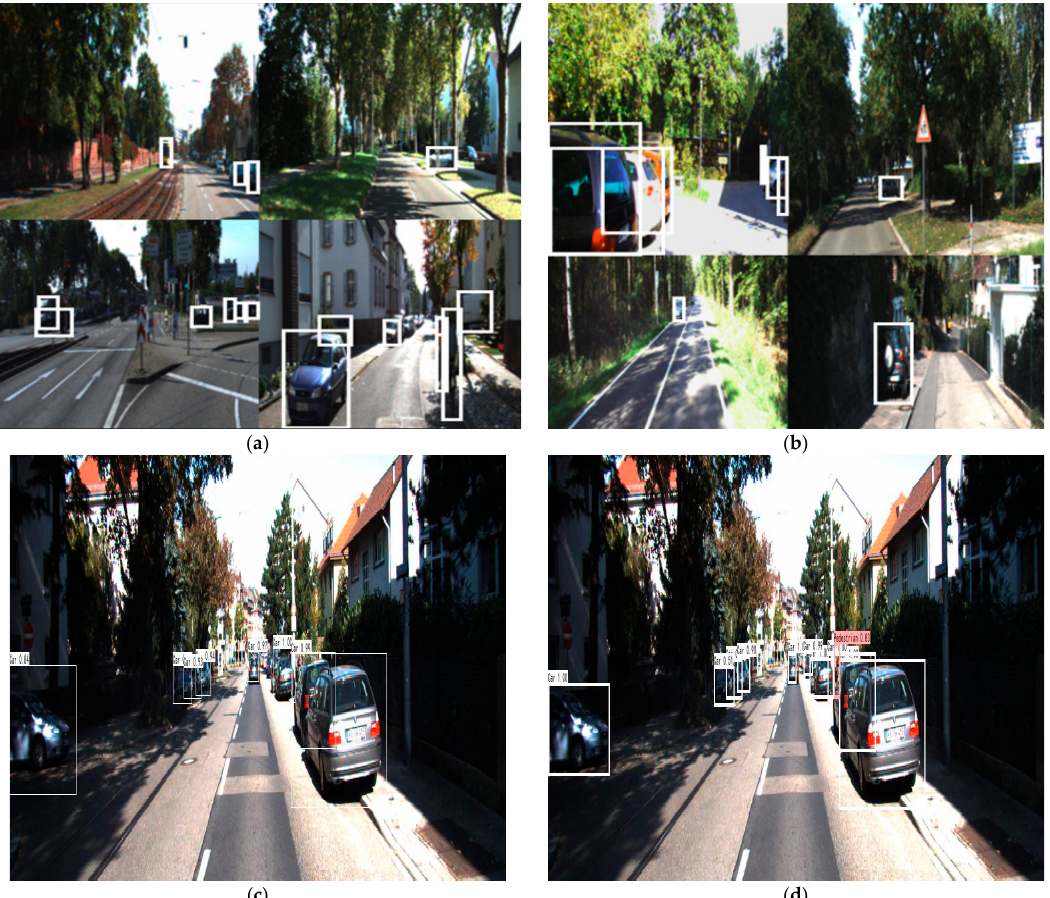
Figure 3. Test effect of Mosaic image enhancement method in different scenarios. ( a ) Small object scenes; ( b ) obscured objects and objects in low-light state scenes; ( c ) with the Mosaic data enhancement detection effect diagram closed; ( d ) with the Mosaic data enhancement detection effect diagram open.